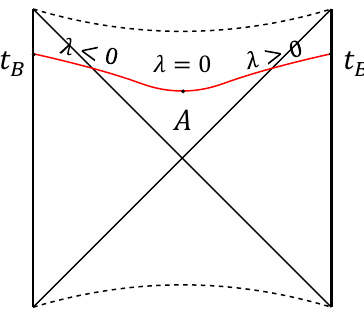
Figure 13 . Set t R = t L = t B . A is the middle point with λ = 0